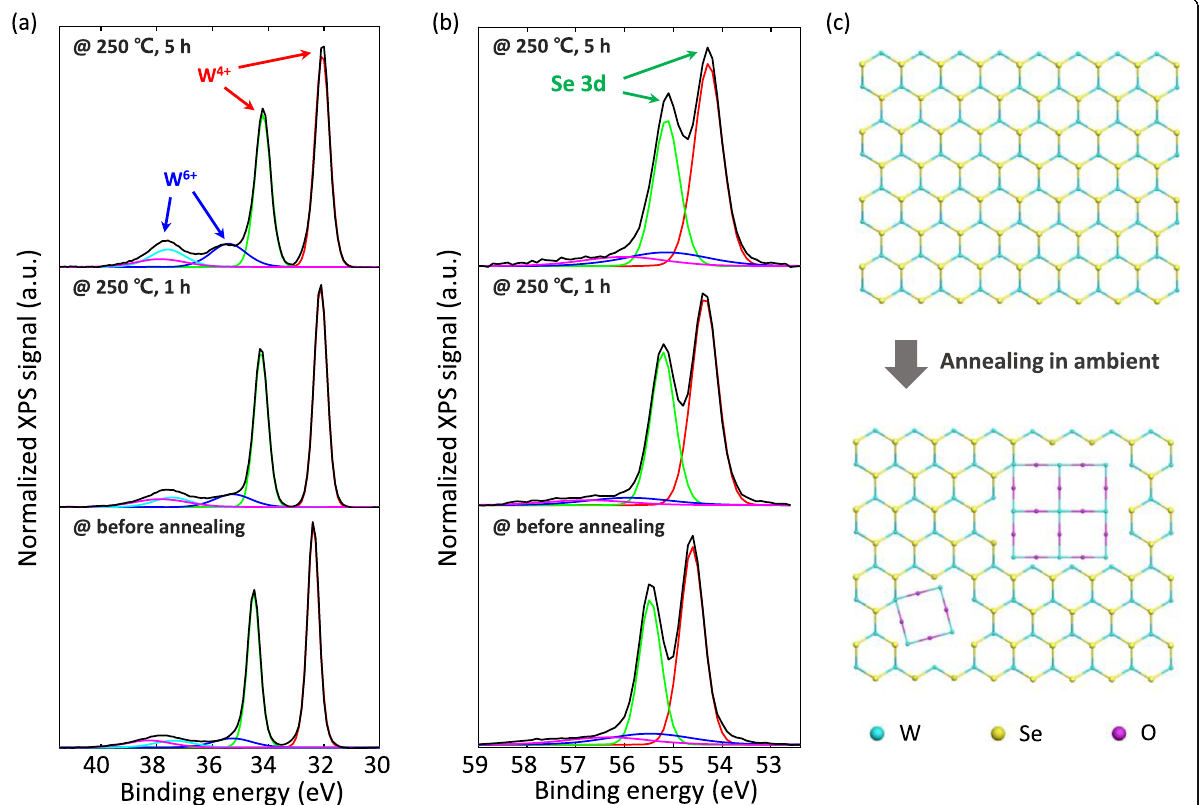
Fig. 5 a Raman spectra of the WSe 2 after annealing in ambient at 200 °C for 60 min (black line), at 350 °C for 60 min (red line), and at 500 °C for 5 min (blue line). Inset images correspond to the optical images before and after annealing in 500 °C, respectively. Scale bar = 15 μ m. b Raman mapping images after annealing at 500 °C integrating with bands at 712 cm − 1 and 806 cm − 1 , respectively. Scale bar = 10 μ m. c Optical bandgap of the WSe 2 before, after annealing in ambient at 250 °C for 30 min, and for 60 min. An inset image is the optical image of a monolayer WSe 2 flake (labeled as sample 1) with scale bar = 10 μ m. d Maximum PL intensity and corresponding PL mapping images with a scale bar of 10 μ